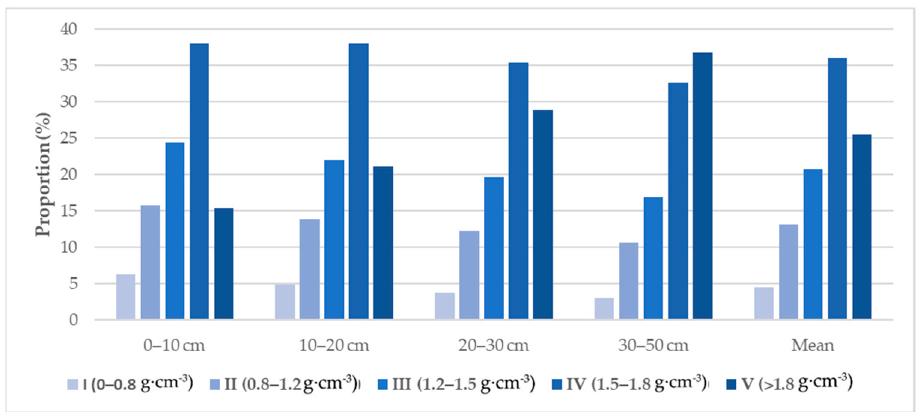
Figure 5. Proportion of stratified soil bulk density.